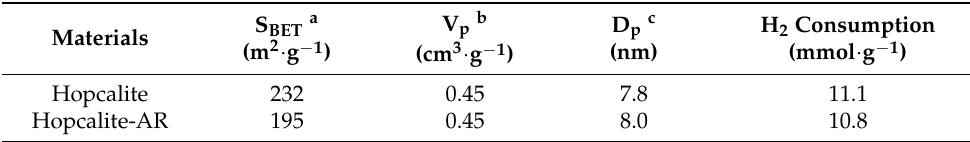
Table 5. Textural and redox properties of the fresh Hopcalite and Hopcalite after reaction (Hopcalite- AR).